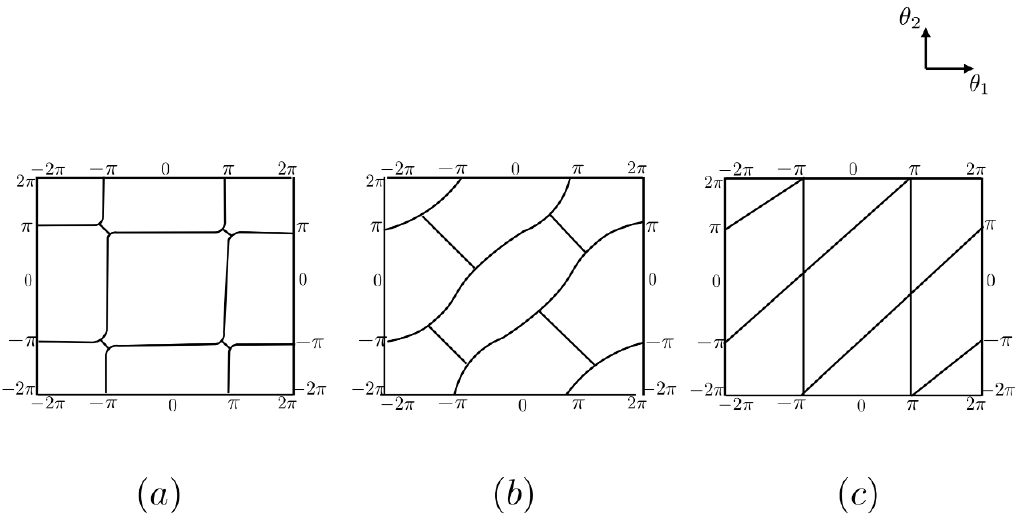
Figure 2 . The qualitative structure of the phase diagram of the bi-fundamental gauge theory with N 1 = N 2 in three limits: (a) Large M , (b) Small M with (cid:3) 1 ’ (cid:3) 2 , (c) (cid:3) 2 ; M (cid:28) (cid:3) 1